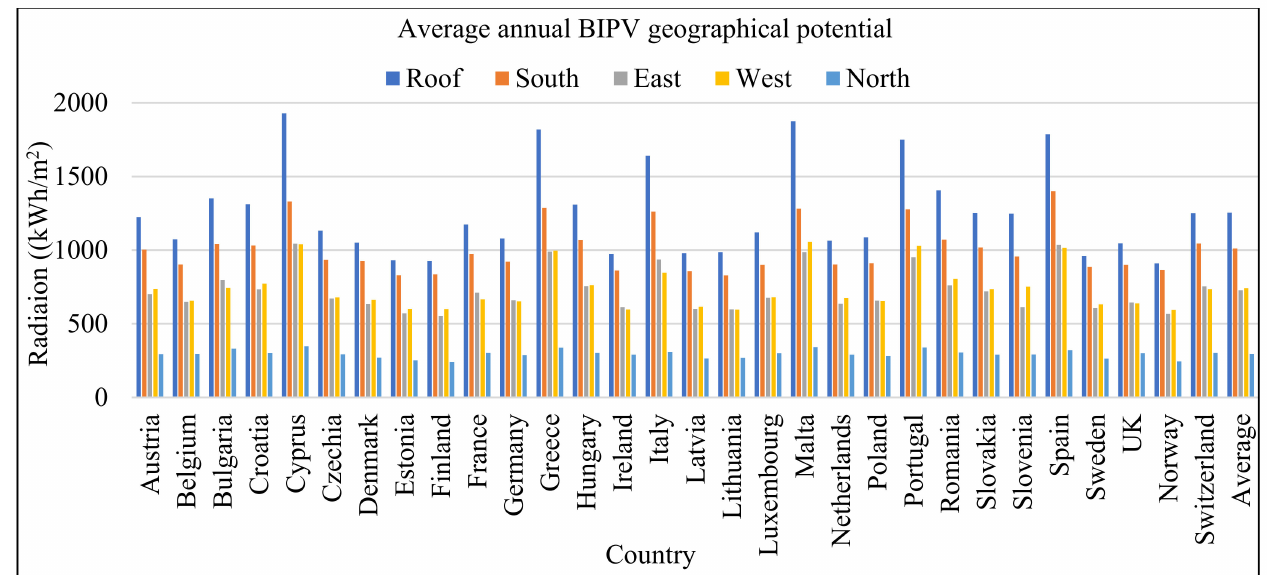
Figure 6. The average annual geographical potential of BIPV systems in